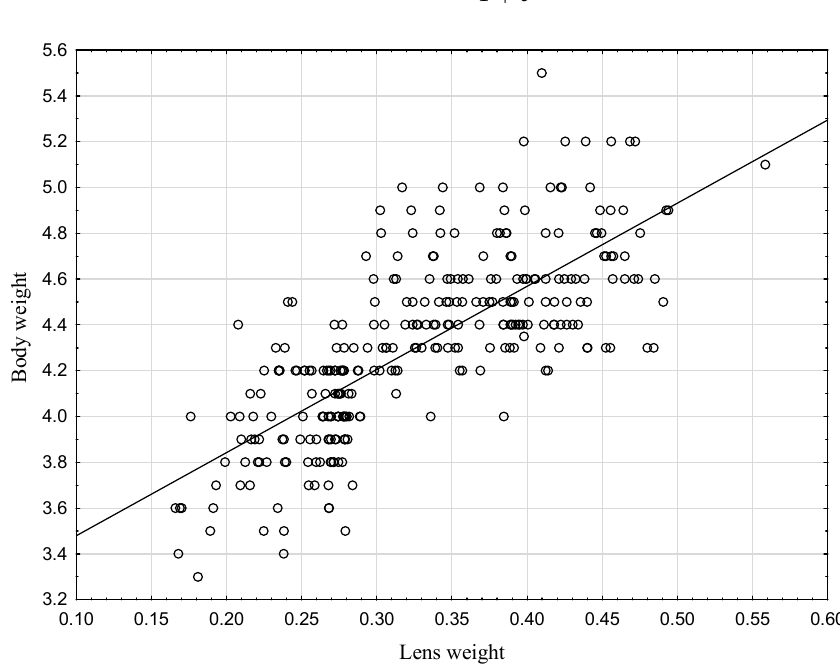
Figure 2 . Scatterplot of body weight and dry lens weight with a fitted regression line . Figure 2. Scatterplot of body weight and dry lens weight with a fitted regression